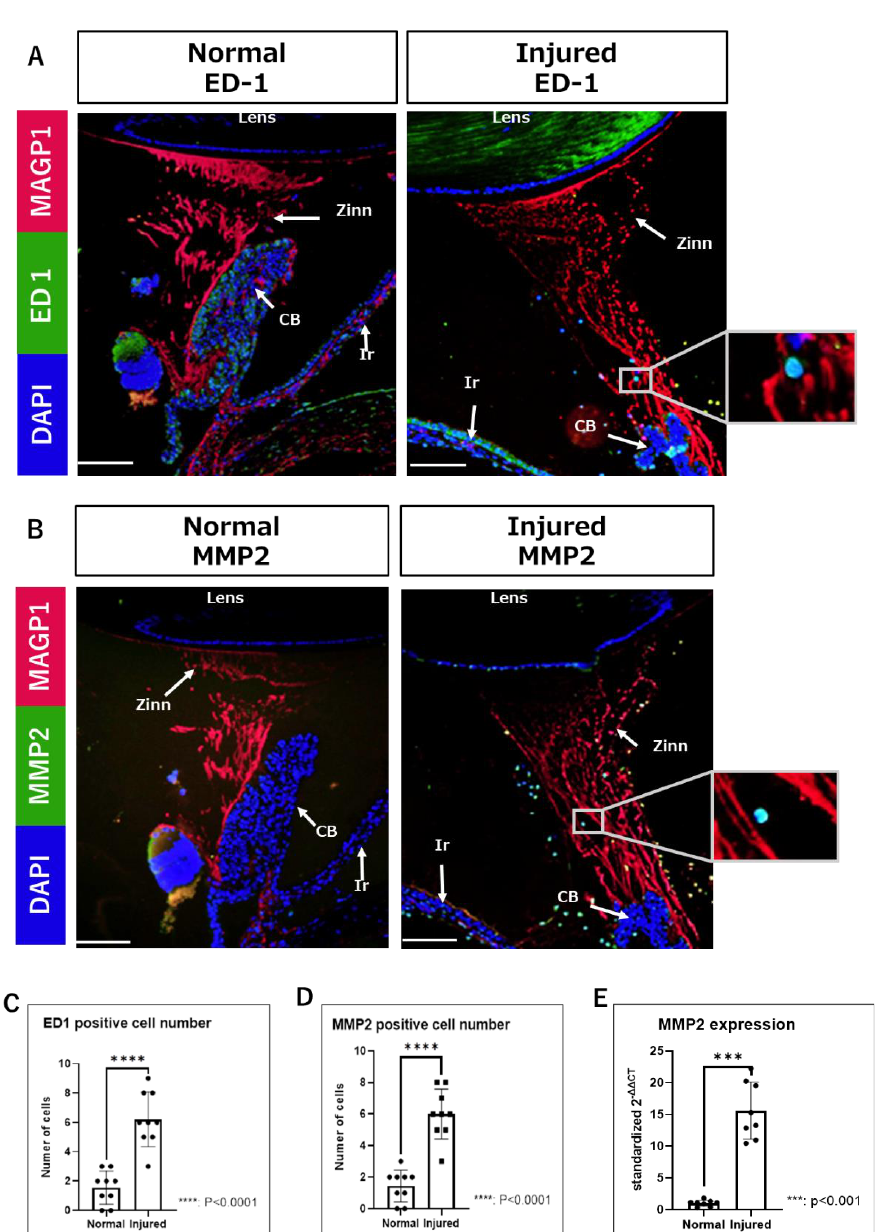
Figure 2. Increased infiltration of ED1-positive and MMP2-positive cells in Zinn’s zonule of the injured groups. ( A , B ) Immunofluorescence observations (magnified 100 × ) were performed on paraffin sections. ( A ) Nuclei were identified using DAPI (blue), macrophages using ED-1 (green), and Zinn’s zonule using anti-MAGP1 (red). ( B ) Nuclei were identified using DAPI (blue), MMP2- expressing cells using anti-MMP2 (green), and Zinn’s zonule using anti-MAGP1 (red). The cells in the white boxes in the figure are magnified. ( C , D ) Nucleated cells infiltrating Zinn’s zonule are increased in the injured group compared to the normal group. Both ED-1-positive and MMP2-positive cells are significantly increased in the injured group compared to the normal group. Four rat specimens were used for the normal and the injured groups, and three 5 µ m sections were imaged from each specimen for both groups. The total number of observation areas was 9 due to the reason of the structural breakdown of Zinn’s zonule. We observed Zinn’s zonule in two locations in each section. ( E ) RT-qPCR was performed two times using RNA extracted from paraffin-fixed sections, showing significantly increased expression of MMP2 in the injured group compared to the normal group. A total of 100 thin sections of 10 µ m thickness for each group were used for the experiments.